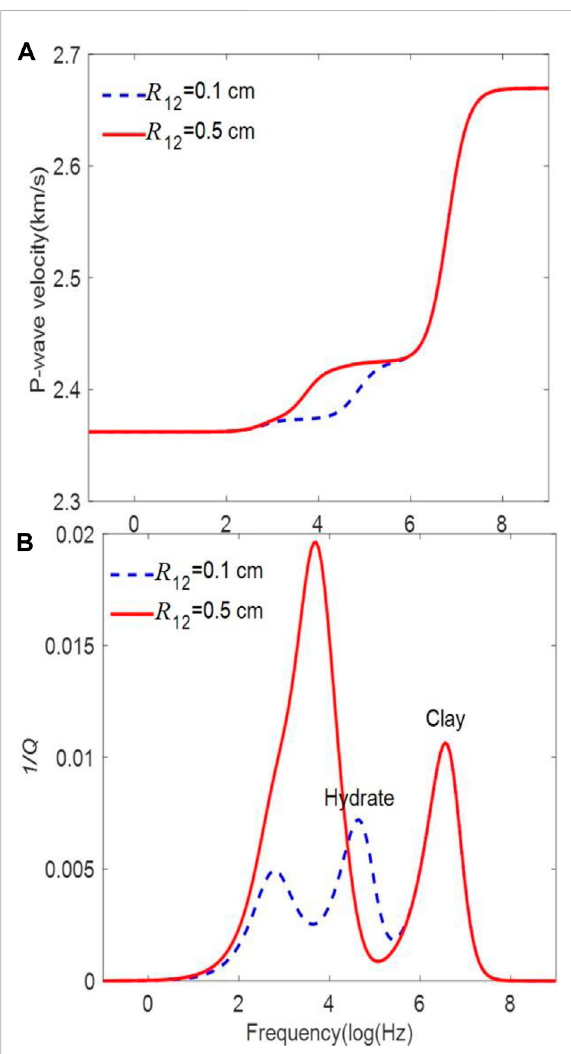
Frequency dependence of the P-wave velocity (A) and attenuation (B) corresponding to the double-porosity model with two radii of the hydrate inclusions.